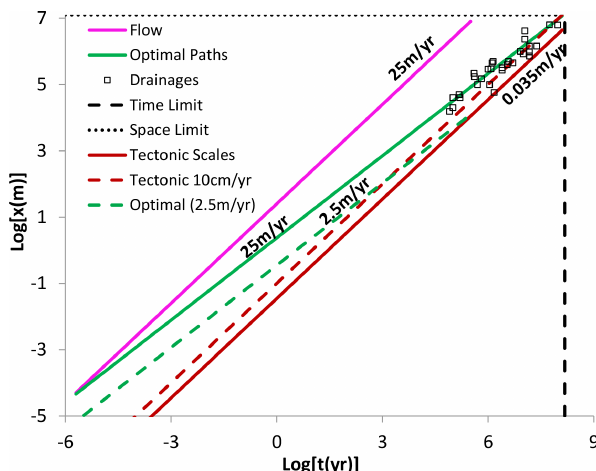
Figure 5. A demonstration that tectonic (constant velocity) and pre- dicted optimal path scaling, when using space and timescales de- fined at the pore scale and for pore-scale flow rates, converge at timescales larger than 1Myr and length scales exceeding 100km. In this, consider that 25myr − 1 is less than a maximum flow rate (35myr − 1 was also found here from data of Aggarwal et al., 2014) and that slower flow rates may also be relevant. For comparison see “Optimal (2.5myr − 1 )”, which shows predictions of Eq. (1) with a flow rate of 2.5myr − 1 instead of 25myr − 1 . If, as appears pos- sible from the figure, drainage basin scaling results are found in the wedge of time and length scales between optimal path scal- ing and tectonic scaling, the range of drainage basin sizes be- comes restricted more sharply due to limited water supply at shorter timescales than the values defined by the intersection of optimal paths with the Wilson cycle timescale. In particular, the timescale at this intersection for a flow rate of 1myr − 1 and a tectonic rate of 0.035myr − 1 is about 300kyr and the length scale is about